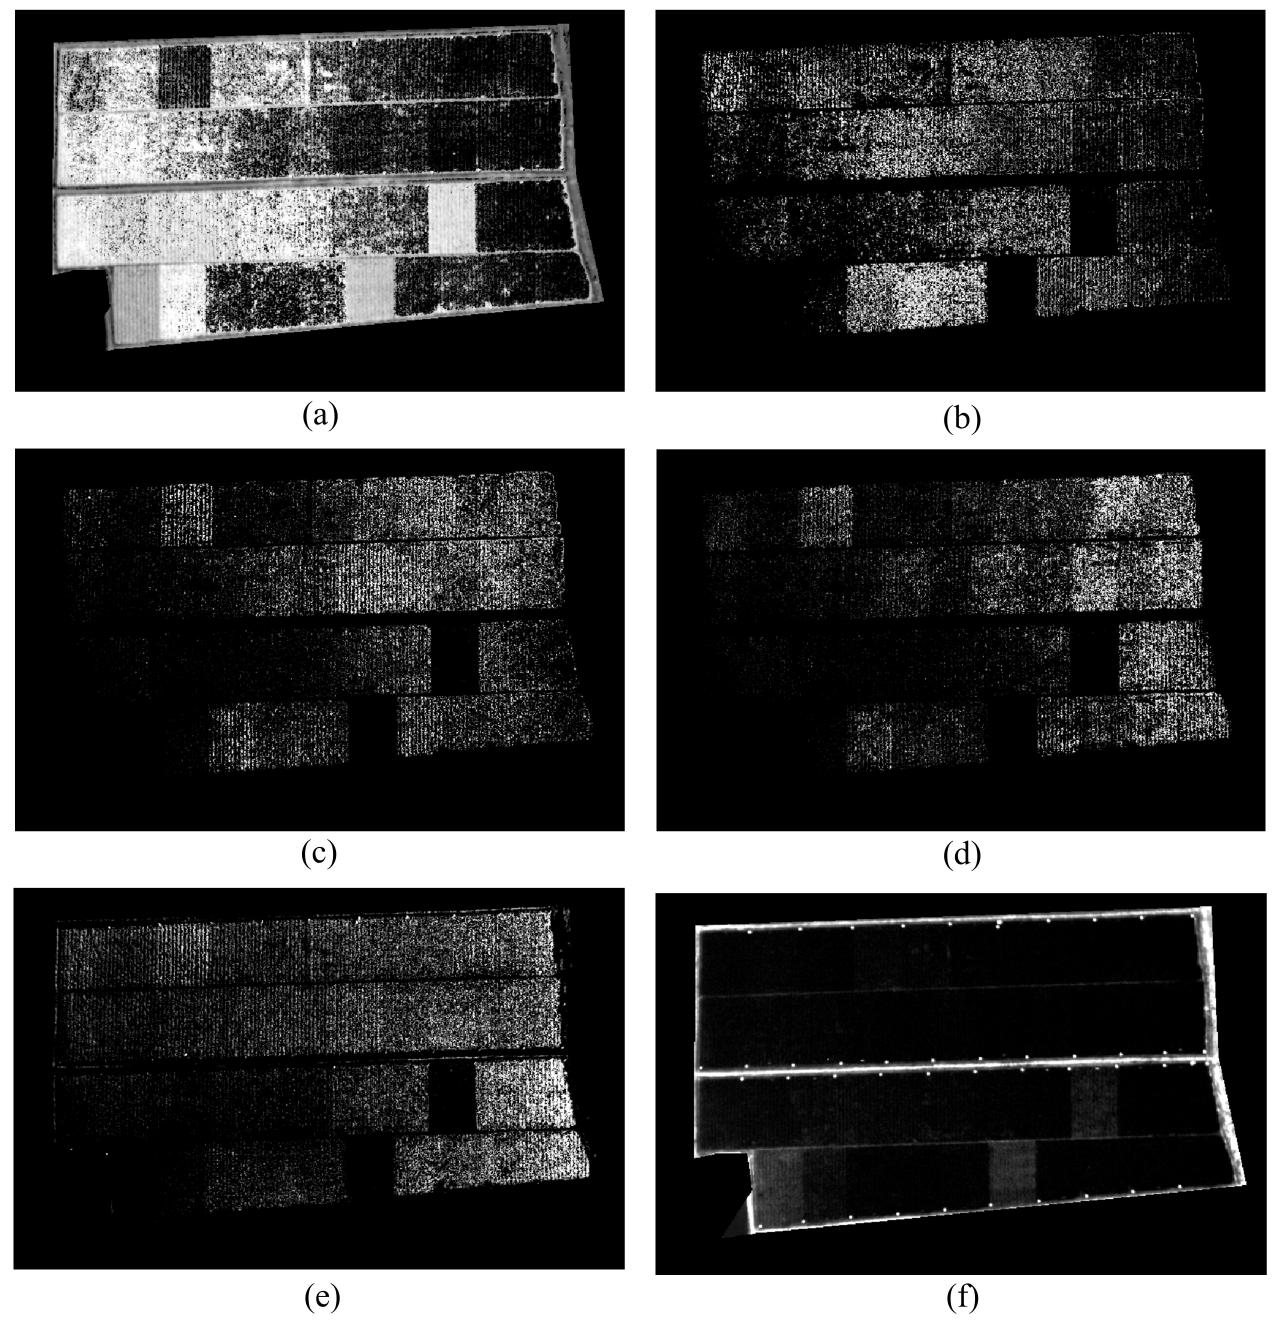
Figure 9. The abundance images of ( a – e ) five foreground and ( f ) one background endmembers of Study Area